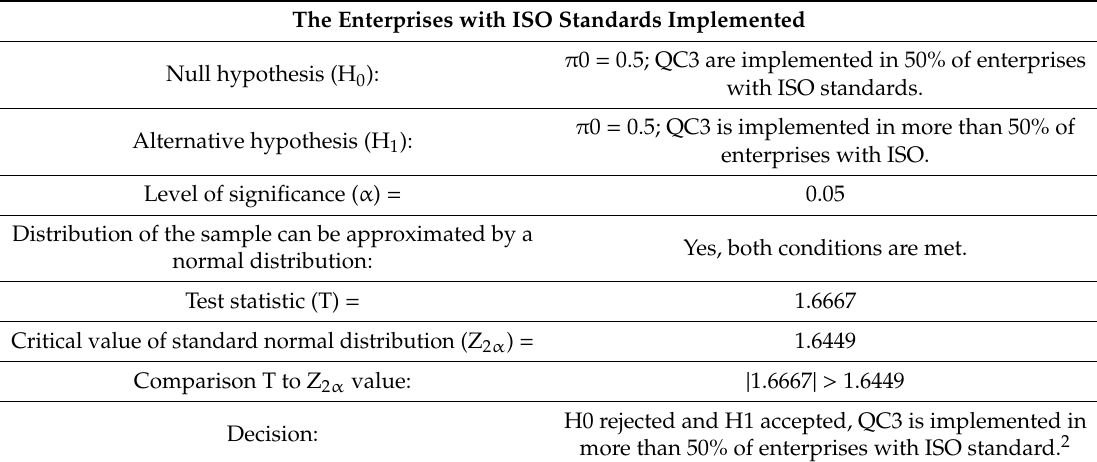
Table 8. The enterprises with ISO standards implemented.